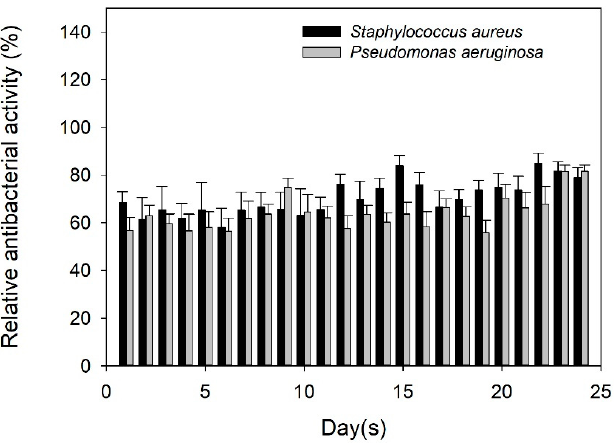
Figure 8. Susceptibility profiles of Staphylococcus aureus and Pseudomonas aeruginosa to released TC.